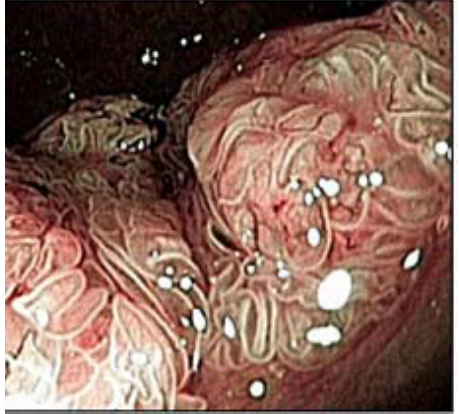
FIGURE 18. Colon: large adenomatous and villous polyp; narrow-band imaging coupled to magnification. Pit pattern classified as IV ( Kudo